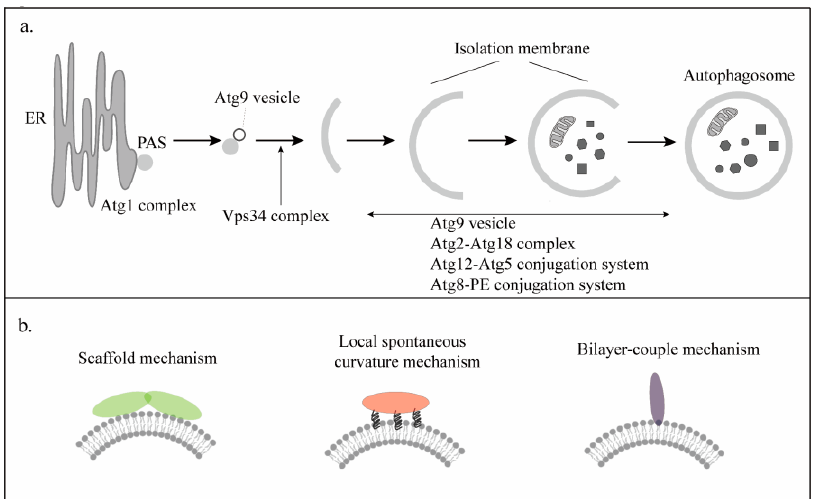
Figure 1. The complexes of autophagy, and the different mechanisms of membrane curvature. ( a ) There are six complexes in autophagy, namely the Atg1 complex, Vps34 complex, Atg2-Atg18 complex, Atg12-Atg5 conjugation system, Atg8-PE conjugation system, and Atg9 vesicle. ( b ) The mechanisms of membrane curvature. Left: The scaffold mechanism. The proteins function as scaffolds that present an intrinsic curvature. Middle: The local spontaneous curvature mechanism. The amphiphilic helices of the protein are embedded in the lipid matrix. Right: The bilayer-couple mechanism. The amphipathic protein domains penetrate only one lipid